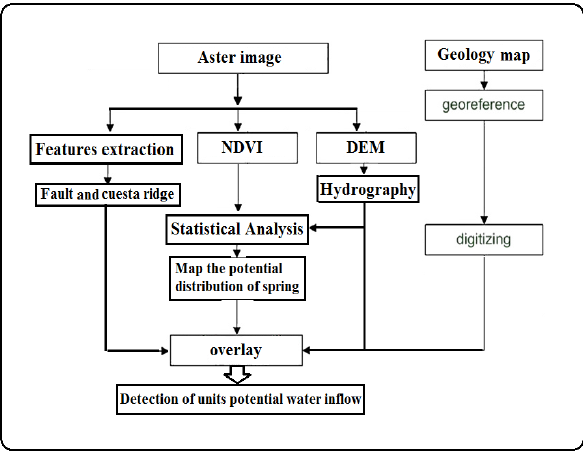
Fig.7. Flowchart of research procedure.